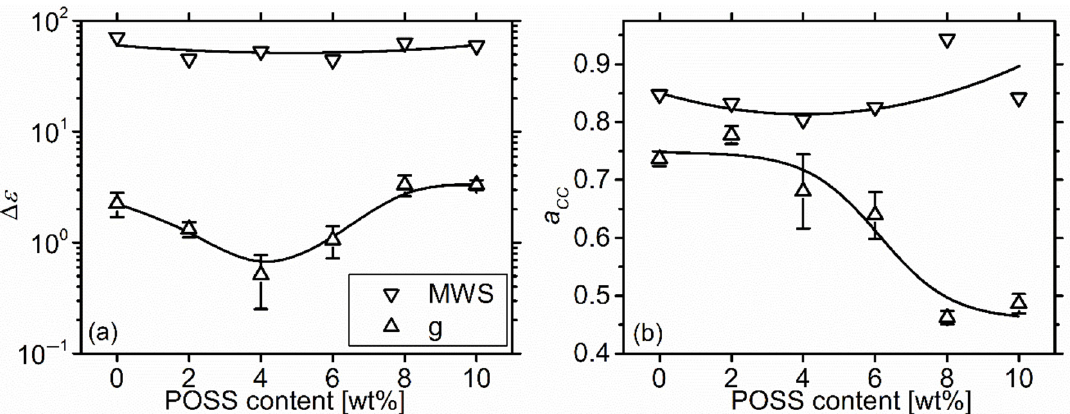
Figure 14. Strength Δε and shape exponent a of the MWS and g relaxation as a function of POSS content at 60 °C. Lines are guides to the eye.